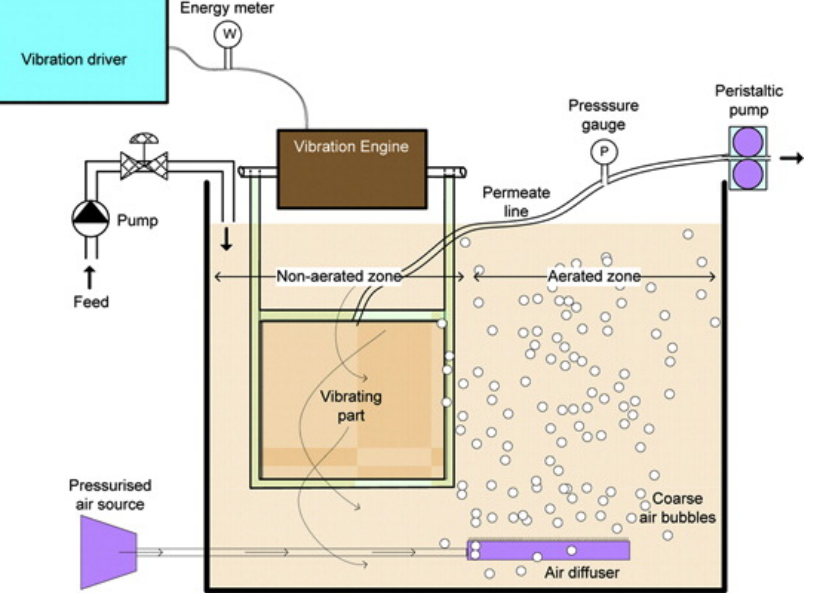
Figure 11. Schematic diagram of novel magnetic vibrating module (MVM) that offers high flux and lower degree of fouling. Reprinted from [171] with permission from Elsevier, 2012.